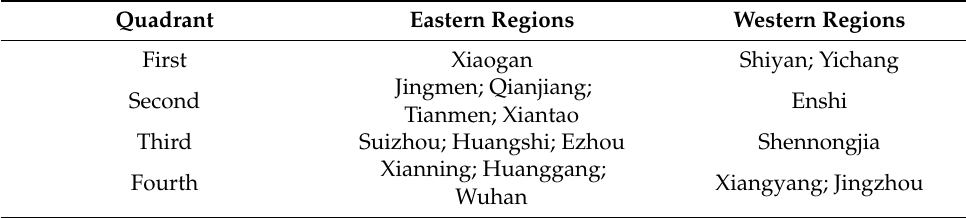
Table 2. Regions corresponding to the points in the scatter plots. Quadrant Eastern Regions Western Regions First